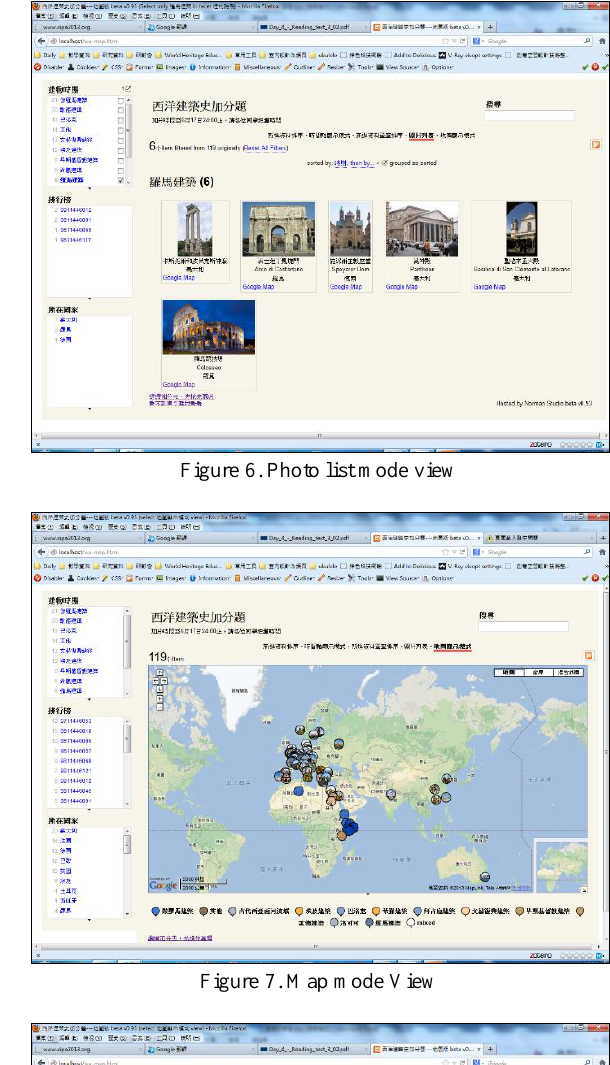
Figure 4. Web page layout design